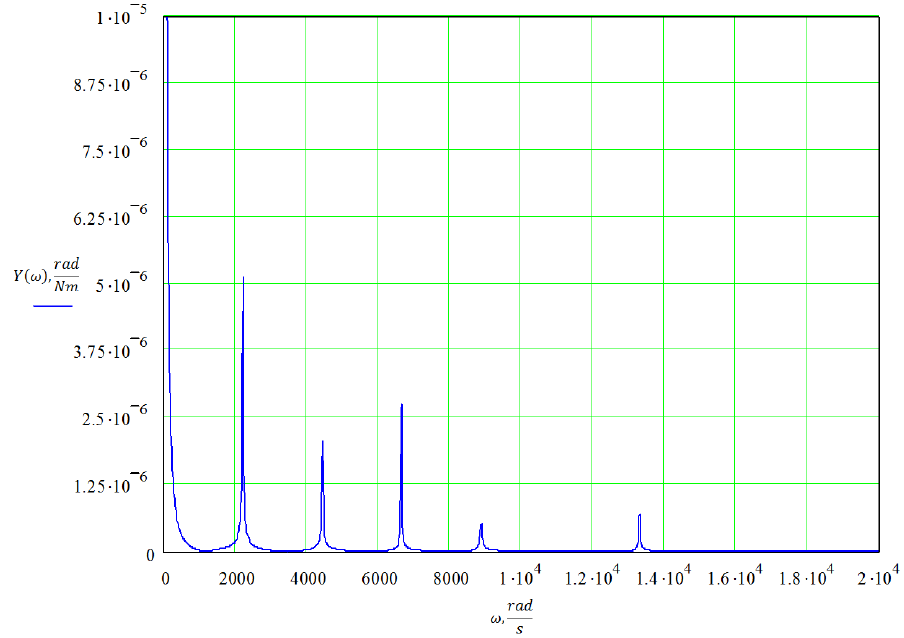
Figure 10. Dynamic characteristics (dynamic flexibility of the system obtained in the result of syn-